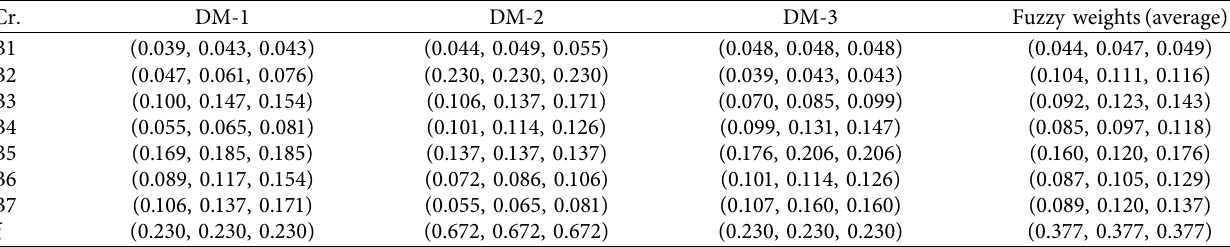
Table 9: For each decision-maker, fuzzy weights of 9 criteria and an associated consistency indicator ( ξ ), as well as average fuzzy weights. Cr.